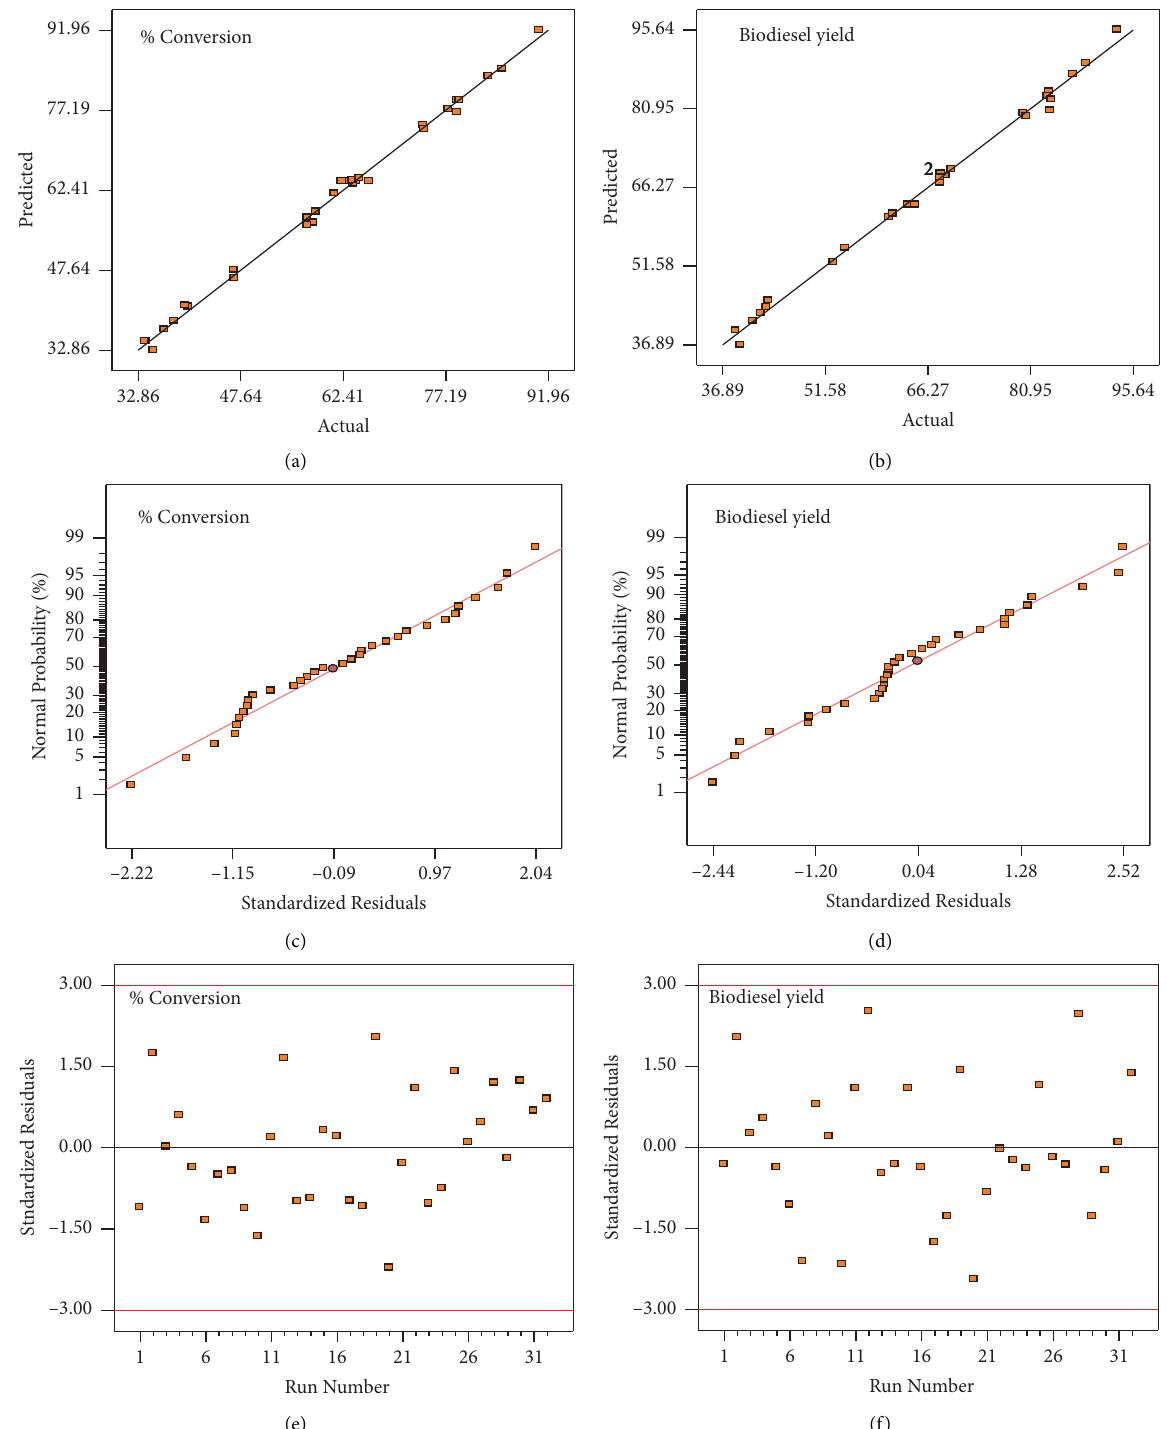
Figure 6: Diagnostic models’ validation plots; predicted versus actual response (a, b), normal probability plots of residuals (c, d), and standardized residuals versus run numbers (e,